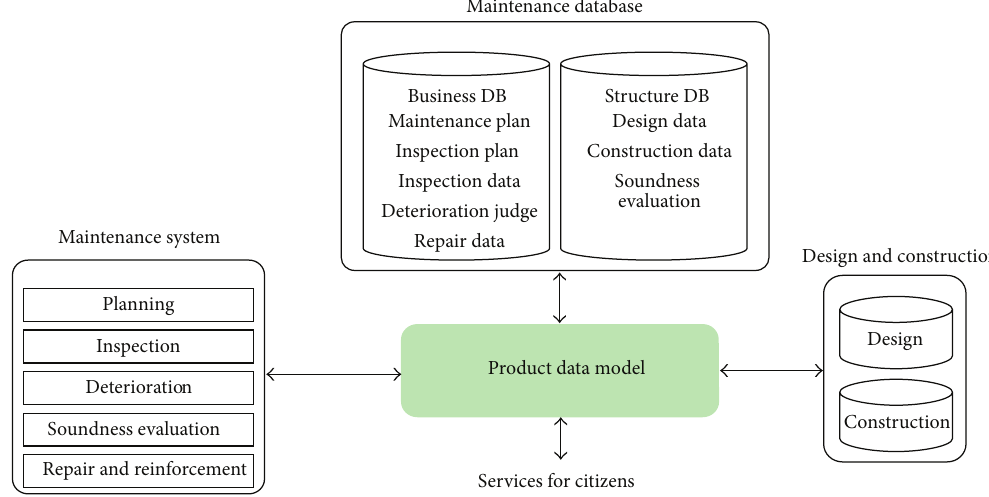
Figure 1: The concept of model oriented management